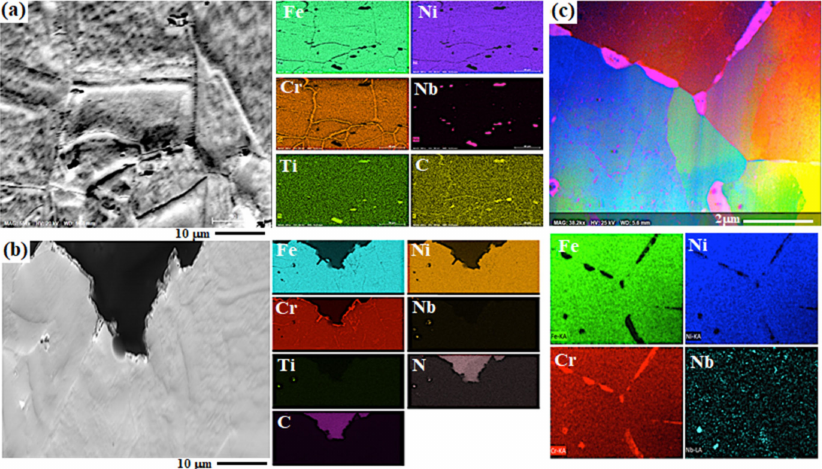
Figure 12. FESEM micrographs with EDX elemental mapping analysis of heat-treated sample at 1200 ◦ C after creep test at 800 ◦ C under 100 MPa stresses, ( a ) inner grains, ( b ) necking region and ( c ) grain boundary